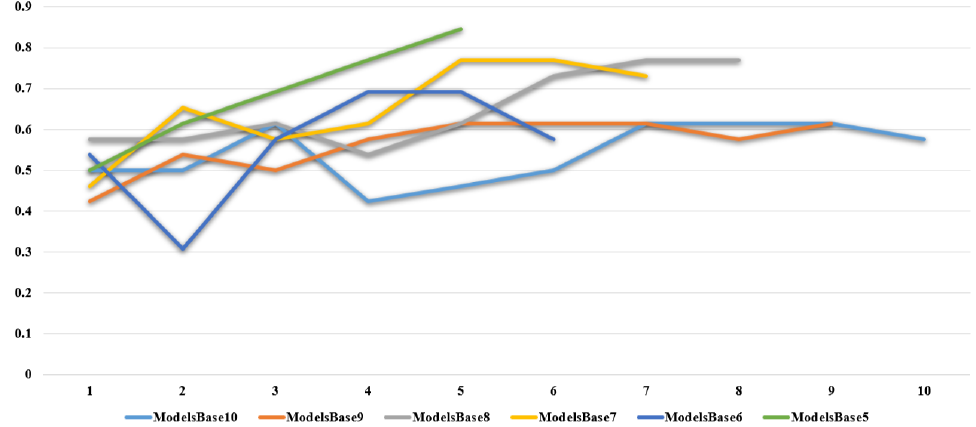
Figure 5. Models’ accuracy